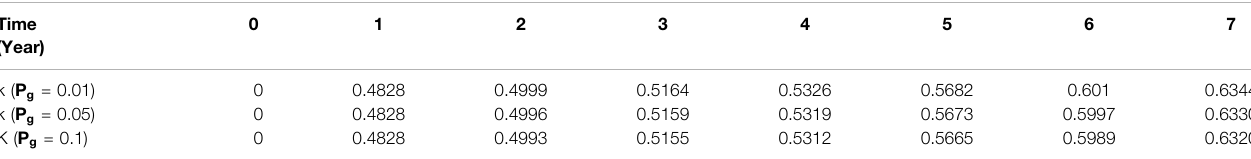
TABLE 2 | The value of transition ratio with different values of P g ( r (cid:2) 0.02). Time (Year)